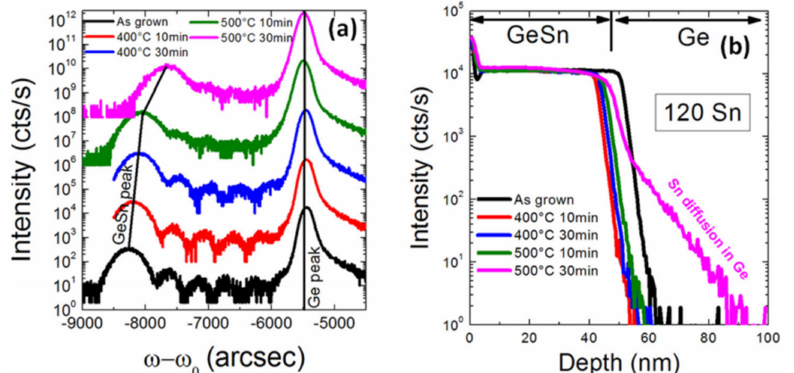
Figure 4. Comparison of ( a ) (004) omega-2 theta scans and ( b ) Sn content profiles of as-grown and annealed Ge 0.92 Sn 0.08 samples under different annealing conditions. Reproduced with permission from [150], AIP Publishing,